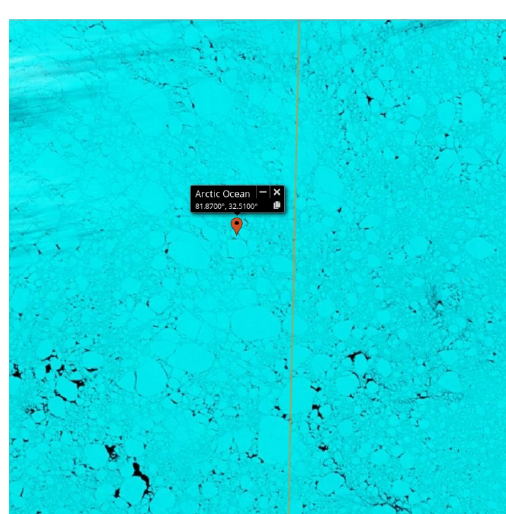
Figure C1. Moderate Resolution Imaging Spectroradiometer (MODIS) screenshot for 3 July 2017. The red symbol indicates Po- larstern ’s location. The orange line indicates the MODIS track. Im- age obtained from EOSDIS Worldview 2021 Version 3.15.